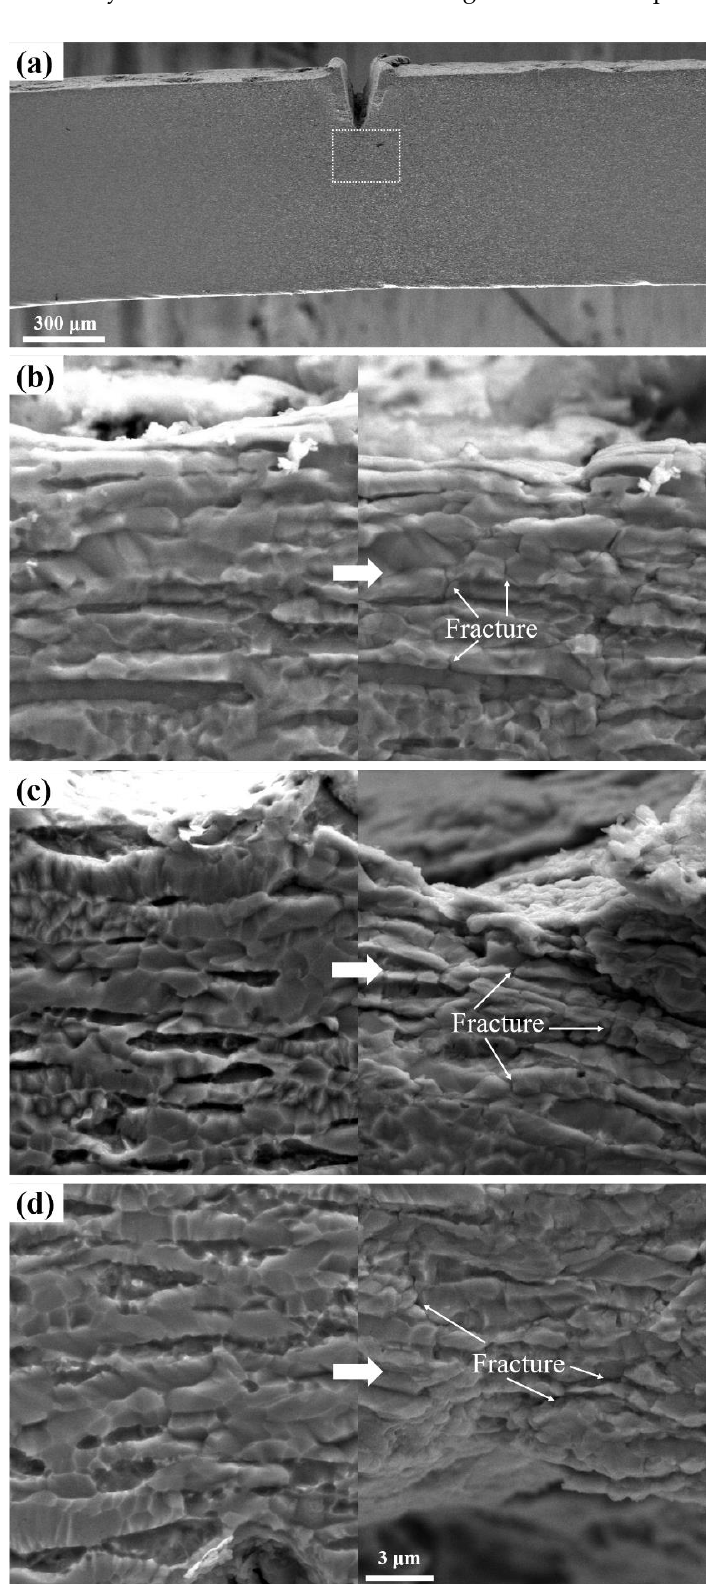
Figure 5. In situ tension: ( a ) observation place, ( b ) R1 alloy, ( c ) R2 alloy, and ( d ) R3 alloy.